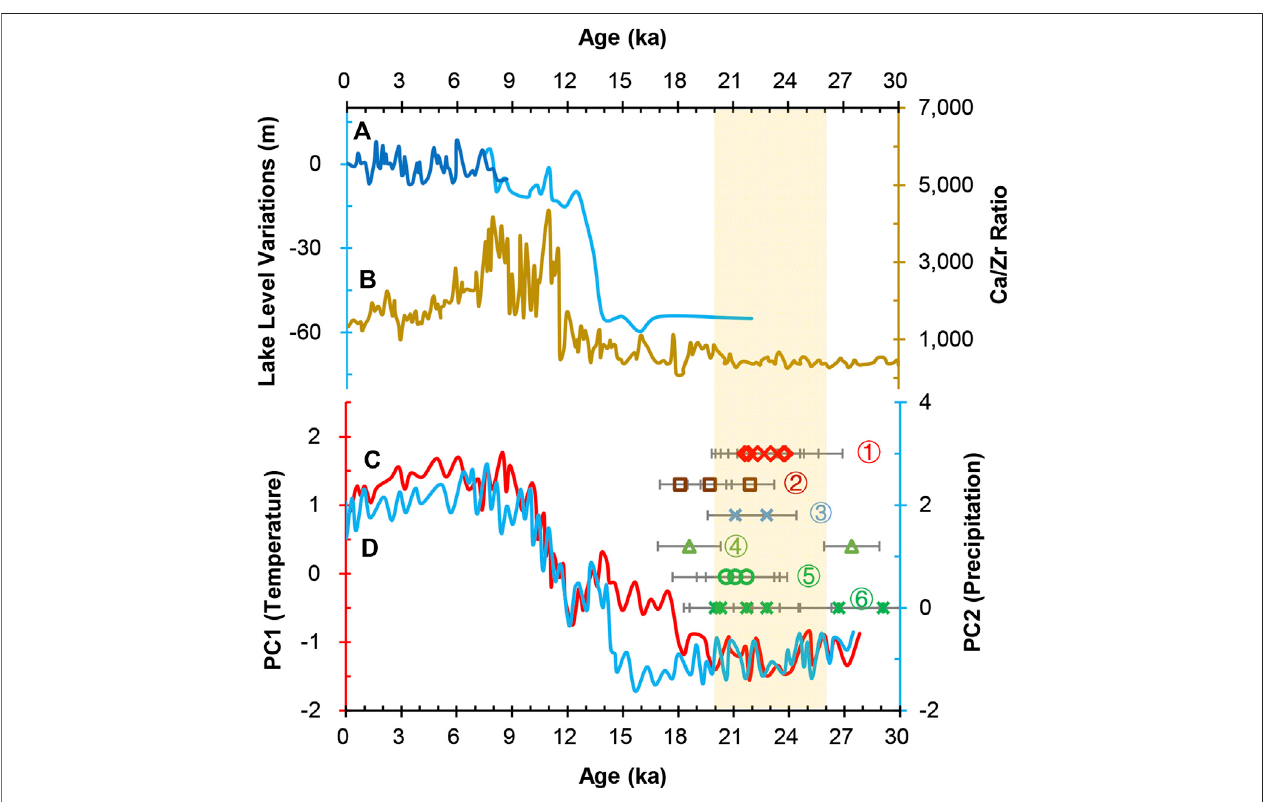
FIGURE 5 | (A) Reconstructed lake level variation curve of Hala Lake (Yan and Wünnemann, 2014). (B) Ca/Zr ratio of lacustrine sediments from Qinghai Lake, representing changes inlake hydrology. Higher values represent more runoff into thelake (Jin et al., 2015). (C) and (D) represent temperature and precipitation changes over Tengchong Qinghai, Yunnan province (Zhang et al., 2020). Precipitation is mainly related to the Indian summer monsoon. The LGM highstand paleoshoreline ages of Dagze Co (this study) ① , Nam Co (Zhou et al., 2020) ② , Dangqiong Co (Kong et al., 2011) ③ and Seling Co (Li et al., 2009) ④ . Ages of the travertine layer containing embedded in human fi ngerprints and footprints at the Quesang archaeological site (Zhang and Li, 2002) ⑤ and ages of fl uvial deposits containing paleolithic stone artifacts at the Nwya Devu archaeological site (Zhang et al., 2018b) ⑥ . The light-yellow band represents the time range of the LGM.